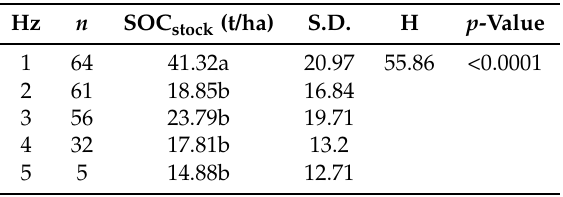
Table 3. Distribution of soil-organic-carbon stock (SOC stock , t/ha) by horizon (Hz). Different letters indicate significant differences according to the Kruskal–Wallis test ( p <